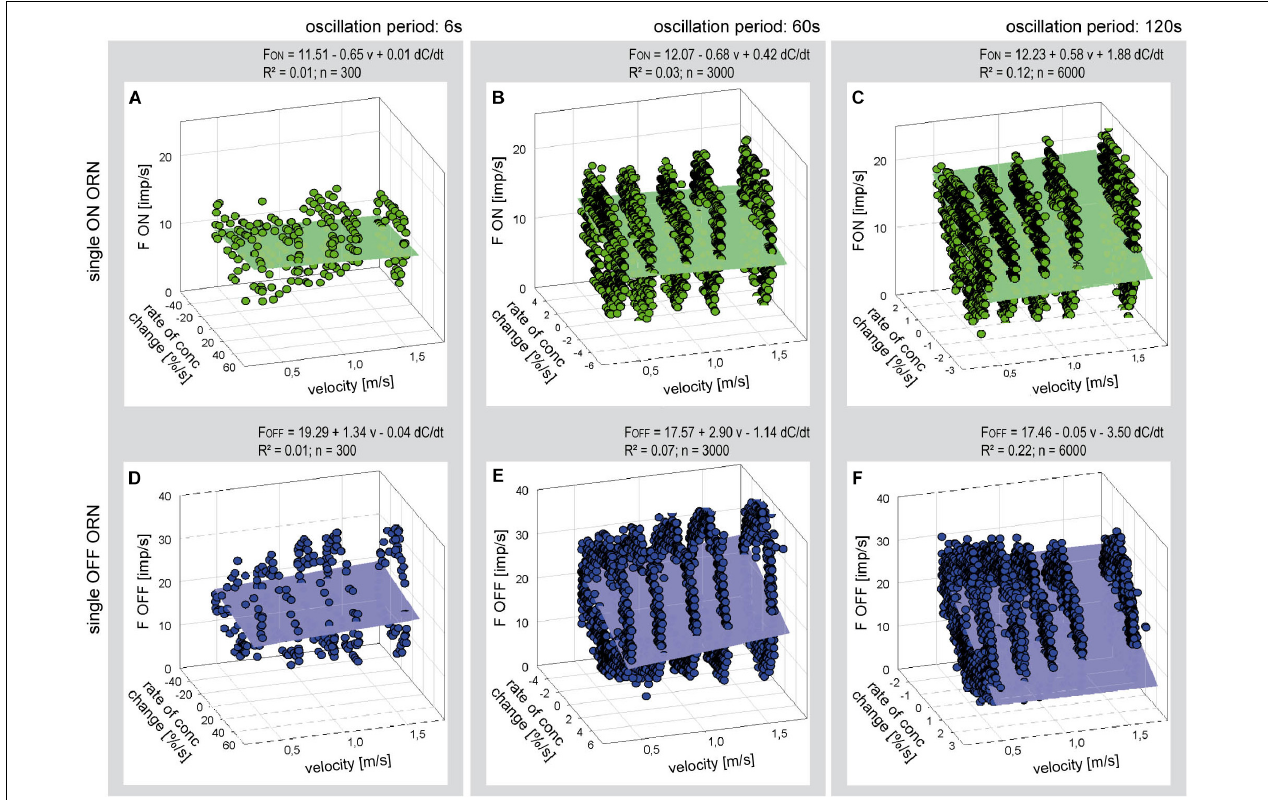
FIGURE 6 | Responses of a single ON ORN (A–C) and a single OFF ORN (D–F) during three different periods of oscillating concentration changes plotted as a function of the rate of concentration change and air flow velocity. Duration of oscillation period: 6 s in panels (A,D) ; 60 s in panels (B,E) ; and 120 s in panels (C,F). Multiple regressions utilizing 3-dimensional planes ( F = y 0 + a v + b d C/ d t ; where F is the impulse frequency, y 0 the height of the regression plane) were calculated to determine the effect of velocity ( a slope) on the responses to the rate of concentration ( b slope) during oscillating changes. Note that the sign of the rate of concentration axis in panels (A–C) is oriented in different direction than in panels (D,E) . R 2 coefficient of determination; n number of points used to calculate regression plane, v